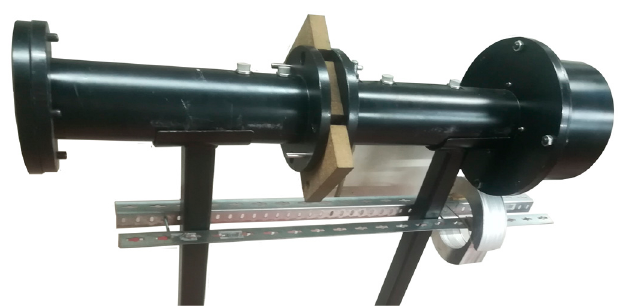
Figure 5. Detail of impedance tube assembly for transmission loss testing.